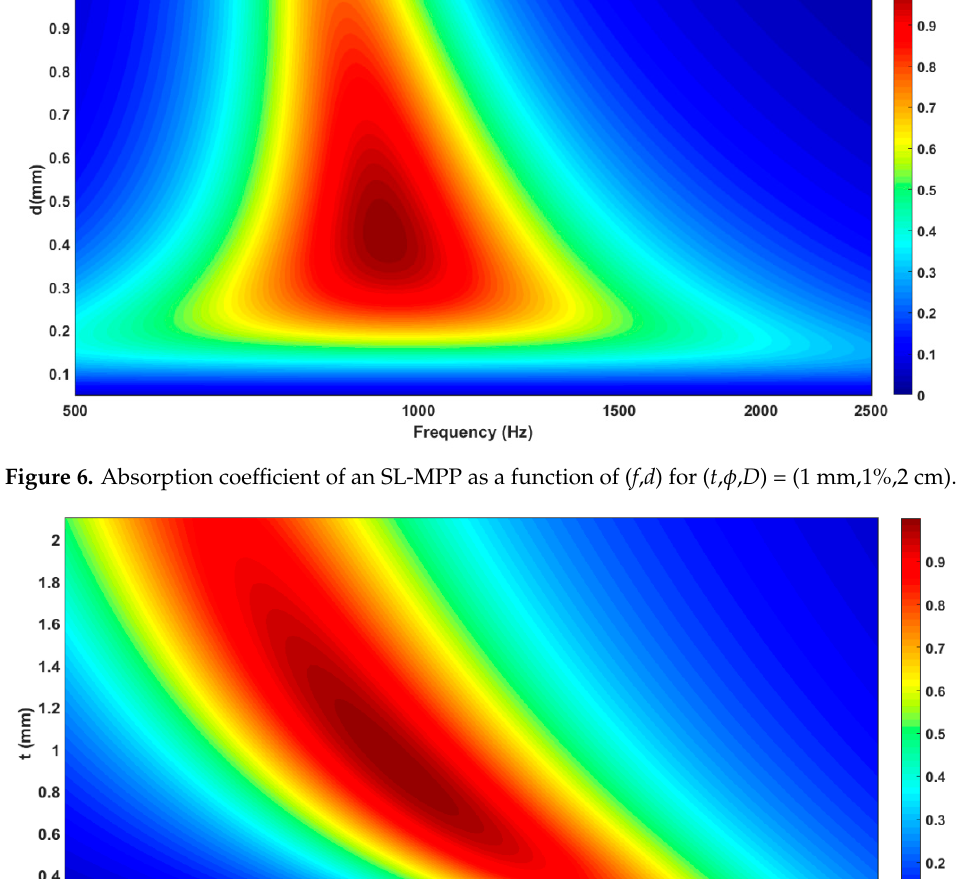
Figure 8. Absorption coefficient of an SL-MPP as a function of ( f , ) for ( d , t , D ) = (0.4 mm,1 mm,2 cm).